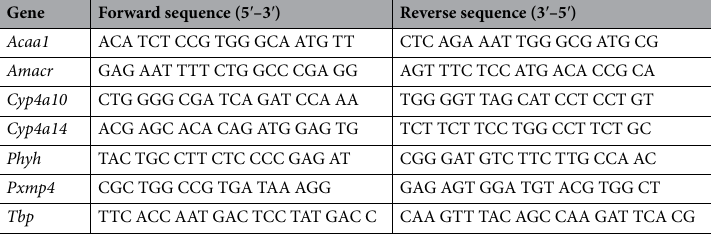
Gene Forward sequence (5 ′ –3 ′